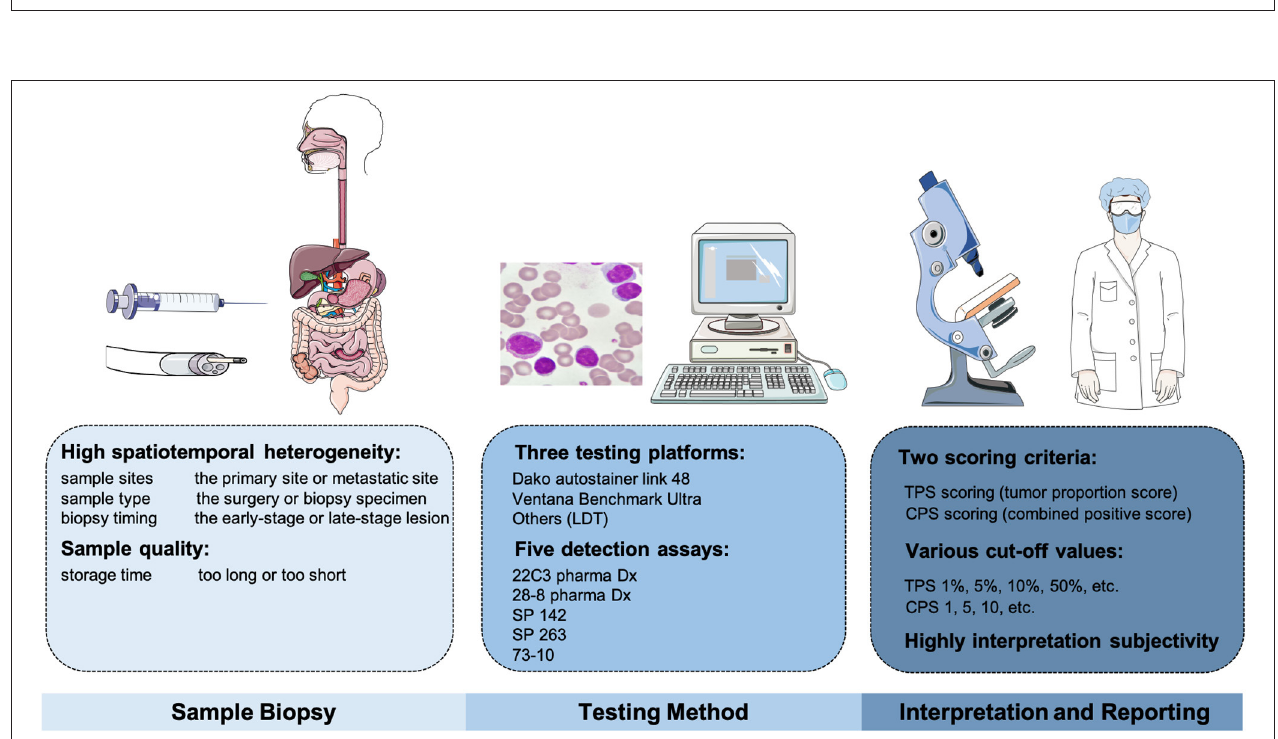
FIGURE 2 | The factors influencing the accuracy of PD-L1 detection, including the sample-biopsy factors, the testing-method factors, and the interpretation factors.